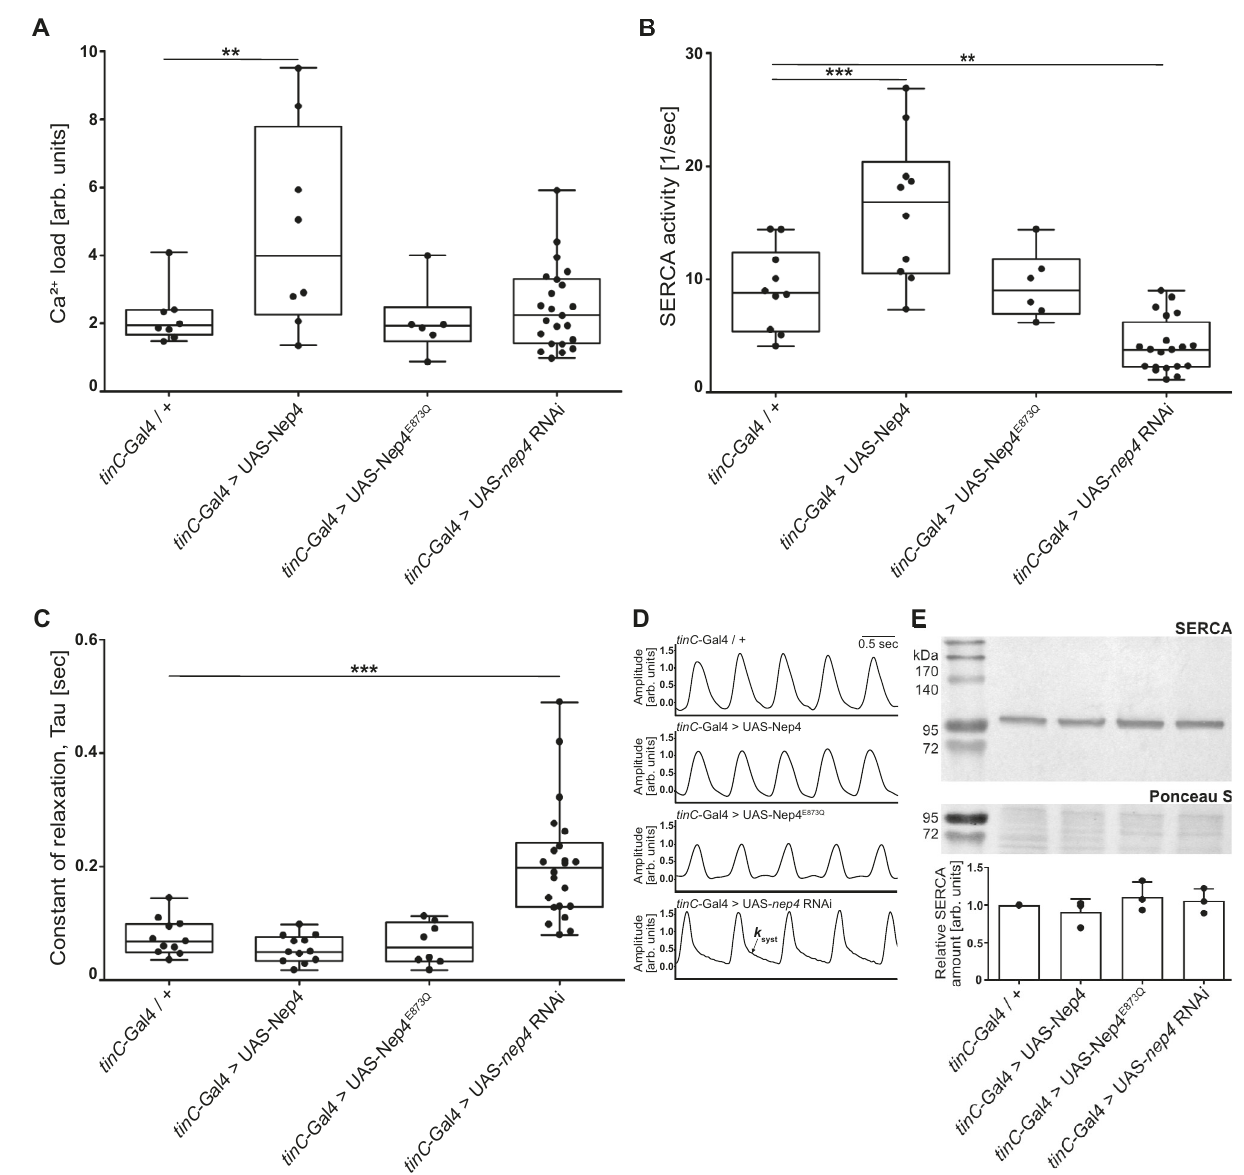
Fig. 2 | Cardiac Ca 2+ homeostasis is affected by altered nep4 expression levels. A Relative to control animals ( tinC -Gal4/+, n =8), sarcoplasmic reticulum Ca 2+ load is increased by 105% in cardiomyocytes overexpressing active Nep4 ( tinC -Gal4> UAS-Nep4, n =8). Overexpression of catalytically inactive Nep4 ( tinC -Gal4>UAS- Nep4 E873Q , n =6)orknockdownofthepeptidase( tinC -Gal4>UAS- nep4 RNAi, n =23) has no signi fi cant effect. B Relative to control animals ( tinC -Gal4/+ n =10), over- expression of active Nep4 ( tinC -Gal4>UAS-Nep4, n =10) results in an increase in SERCA activity by 91%, while knockdown of the peptidase ( tinC -Gal4>UAS- nep4 RNAi, n =20) reduces SERCA activity by 57%. Overexpression of catalytically inac- tiveNep4( tinC -Gal4>UAS-Nep4 E873Q , n =6)hasnosigni fi canteffect. C Theconstant of relaxation (Tau) is only affected by the knockdown of nep4 . Relative to controls ( tinC -Gal4/+, n =11), corresponding animals ( tinC -Gal4>UAS- nep4 RNAi, n =22) exhibit a 2.9-fold increase in Tau. Overexpression of active ( tinC -Gal4>UAS-Nep4,